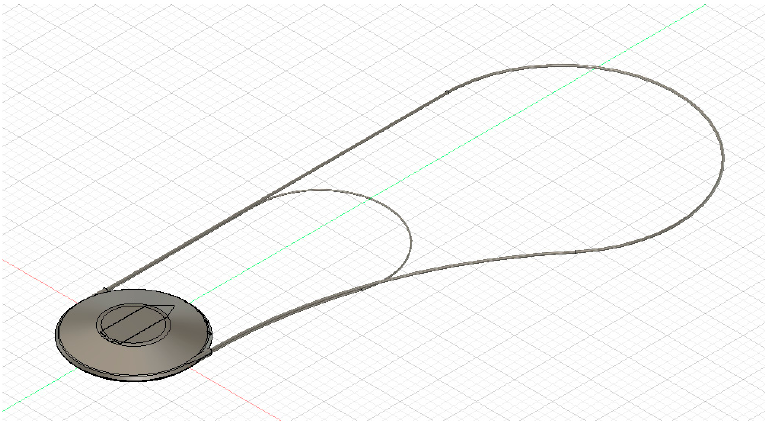
Aerospace 2022 , 9 , x FOR PEER REVIEW Figure 8. TA2 construction (fabric not shown). Figure 8. TA2 construction (fabric not shown).